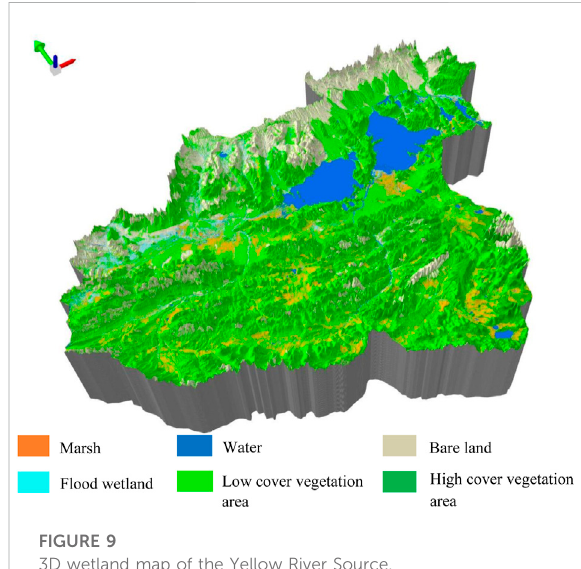
Slope characteristics of wetlands in the source of the Yellow